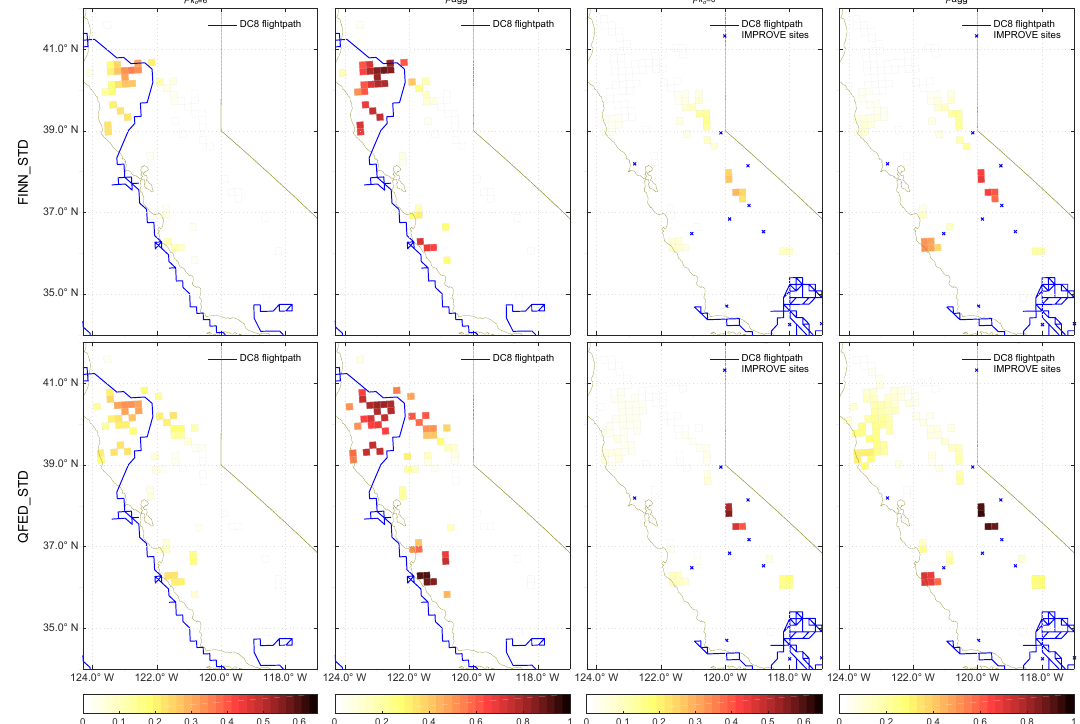
Figure 12. BB error reduction in the final outer loop ( ρ k ) and aggregated across all outer loops ( ρ agg ) for the two primary BB scenarios o = 6 on 22 June 00:00–23:00Z and 23 June, 00:00Z–24 June 23:00Z. The ARCTAS-CARB DC8 flightpath and IMPROVE sites at model grid centers are overlaid.